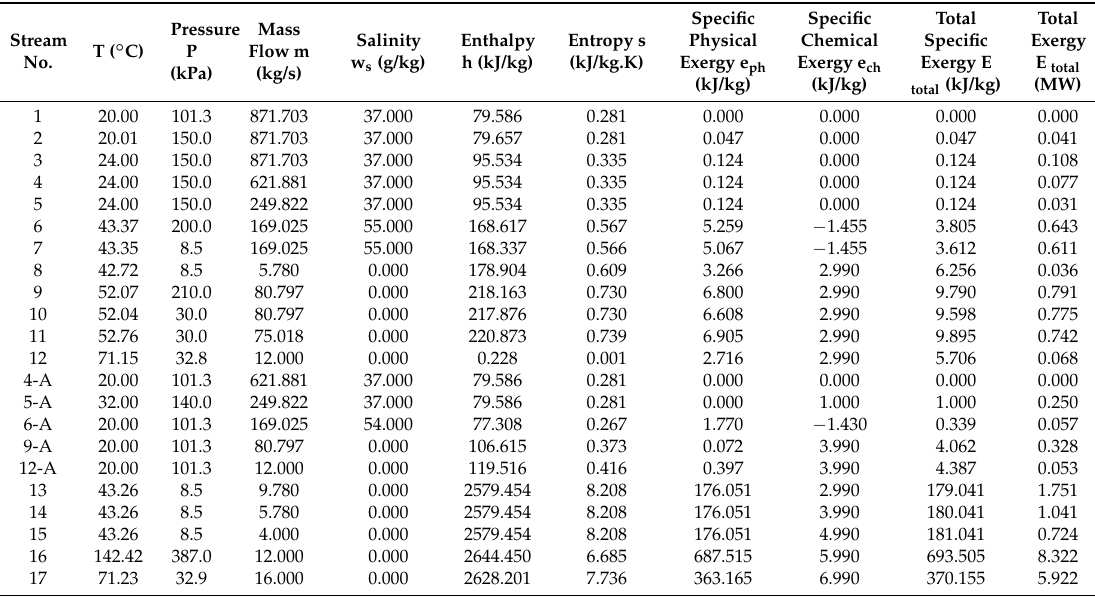
Table 5. Exergetic data of all streams in the proposed system with preheating.